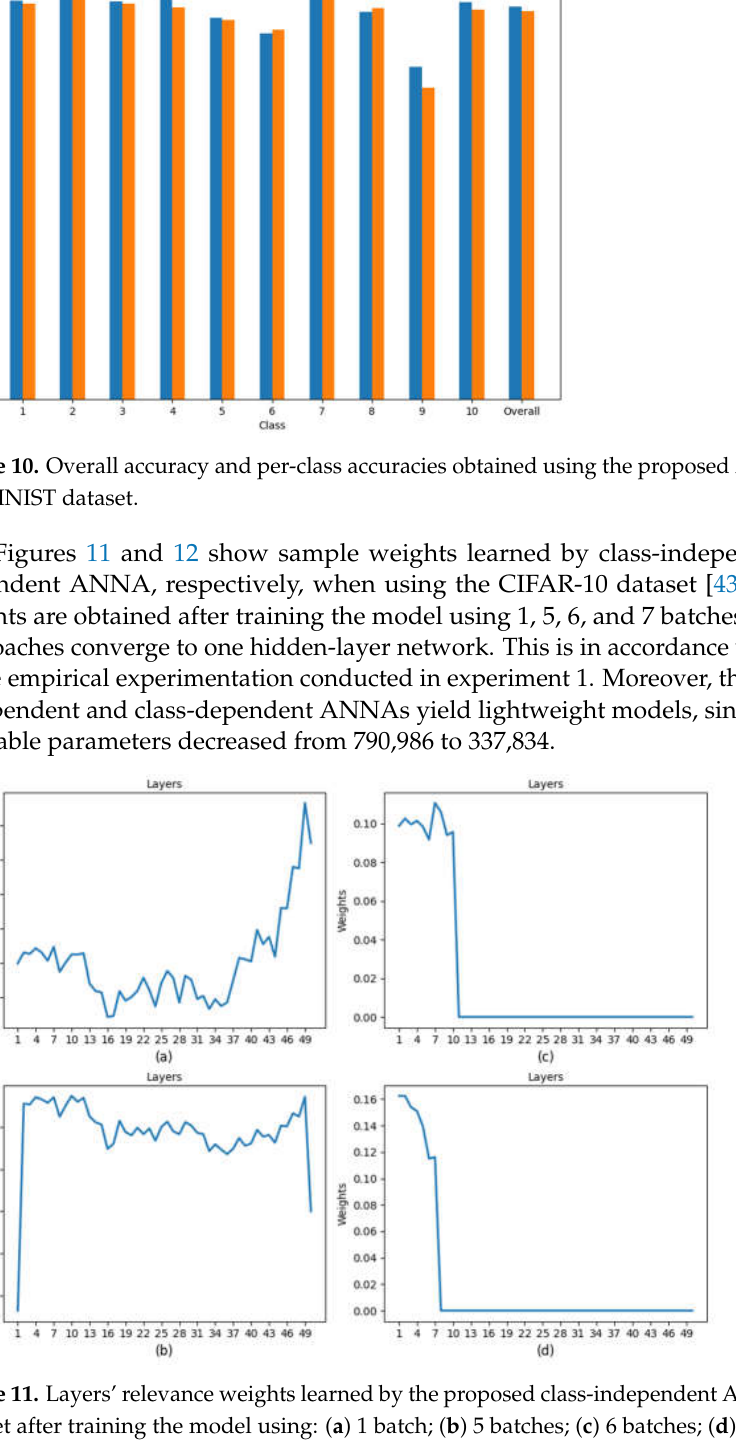
Figure 12. Layers’ relevance weights learned by the proposed class-dependent ANNA on CIFAR- 10 dataset after training the model using: ( a ) 1 batch; ( b ) 5 batches; ( c ) 6 batches; ( d ) 7 batches.